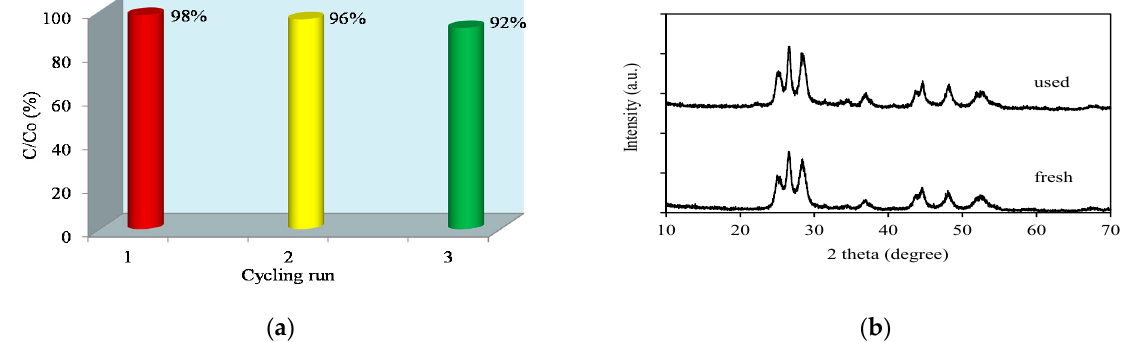
Figure 15. ( a ) Cycling runs and ( b ) XRD patterns of 1.0 wt% Pt / AgInS 2 photocatalyst before and after the experiments.